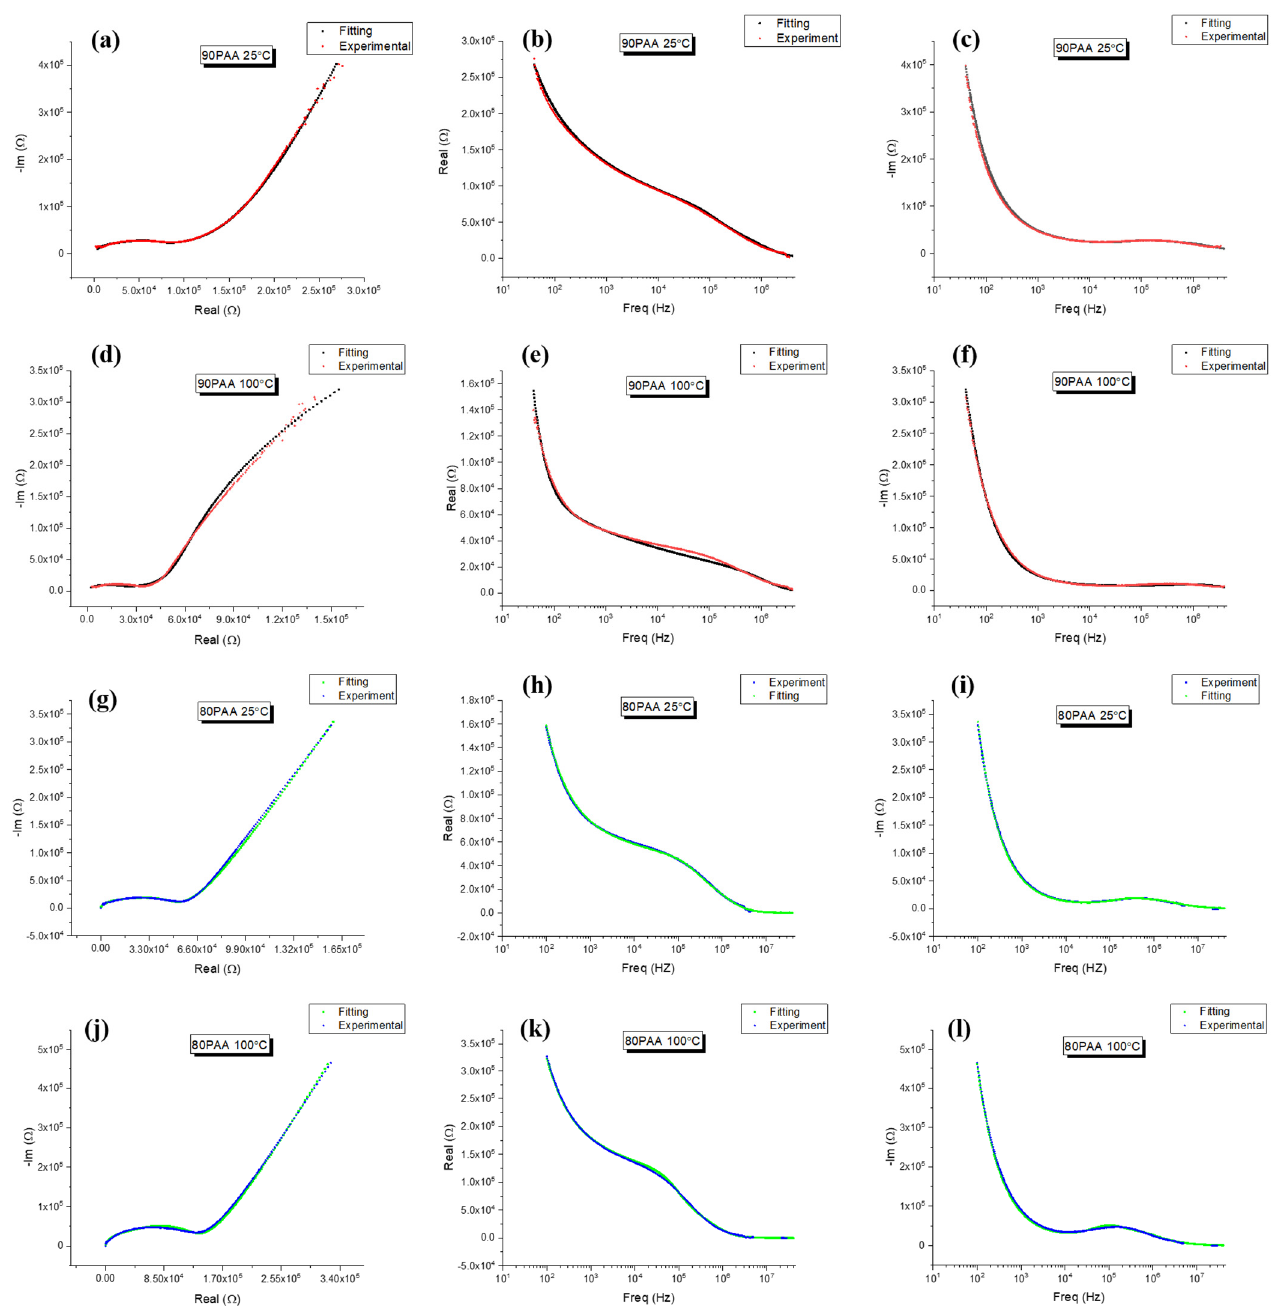
Figure 13. Electrical response equivalent circuit model fits comprising the Nyquist (-m vs. Re plots) and both Bode plots (both Re and -Im vs. frequency) for each case: ( a – c ) 10% binder content sample at 25 °C; ( d – f ) 10% binder content sample at 100 °C; ( g – i ) 20% binder content sample at 25 °C; ( j – l ) 20% binder content sample at 100 °C.